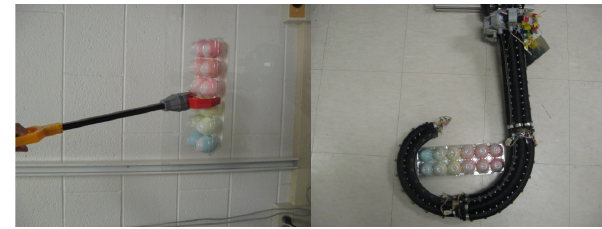
Figure 9. Grasping fragile objects – using a parallel jaw gripper (unsafe grasp) and the Octarm.